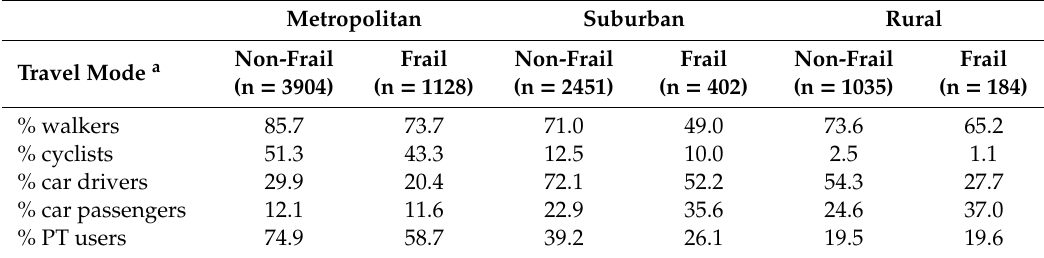
Table 2. Travel modes by locality and frailty status.